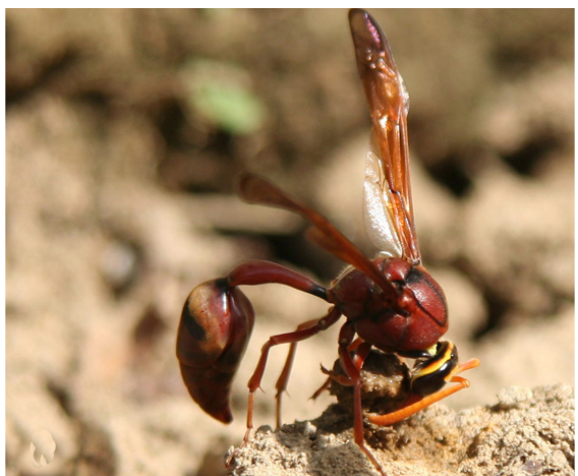
middle above black; forewing basally flavohyaline and apically fuscohyaline, with a slight purplish refringes. Head above the antenna and thorax closely and lightly punctured; clypeus pyriforme, its apex truncate; gaster smooth and shining with the surface minutely aciculate. Male: Structure similar to female in general appearance but smaller and slighter.